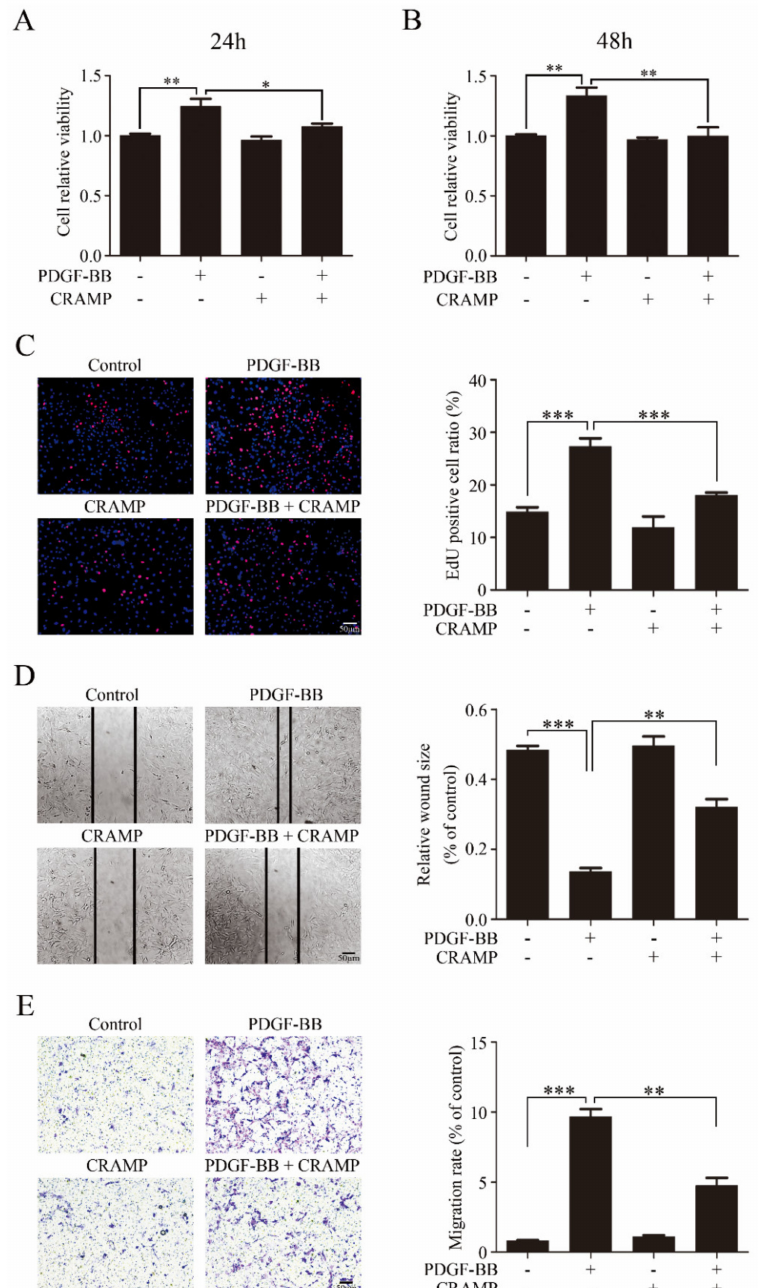
Figure 2. CRAMP inhibits PDGF-BB elevated VSMC proliferation and migration. ( A , B ) VSMC were pretreated with CRAMP (100 ng / mL) for 2 h and then stimulated with PDGF-BB (20 ng / mL) for 24 h or 48 h. Cell viability was detected using 3-(4, 5-dimethylthiazol-2-yl)-2, 5-diphenyl tetrazolium bromide (MTT) assay. Data of 3 independent experiments is presented as mean ± SEM. ** p < 0.01 compared with control, n = 8. ( C ) VSMC were pretreated with CRAMP (100 ng / mL) for 2 h and then stimulated with PDGF-BB (20 ng / mL) for 24 h. Proliferation of VSMC was detected using EdU assay. Data of 3 independent experiments is presented as mean ± SEM. *** p < 0.001 compared with control, n = 6. ( D , E ) VSMC were pretreated with CRAMP (100 ng / mL) for 2 h and then stimulated with PDGF-BB (20 ng / mL) for 24 h. Proliferation of VSMC was detected using wound healing assay ( D ) and transwell assay ( E ). Data of 3 independent experiments is presented as mean ± SEM. ** p < 0.01, *** p < 0.001 compared with control, n =